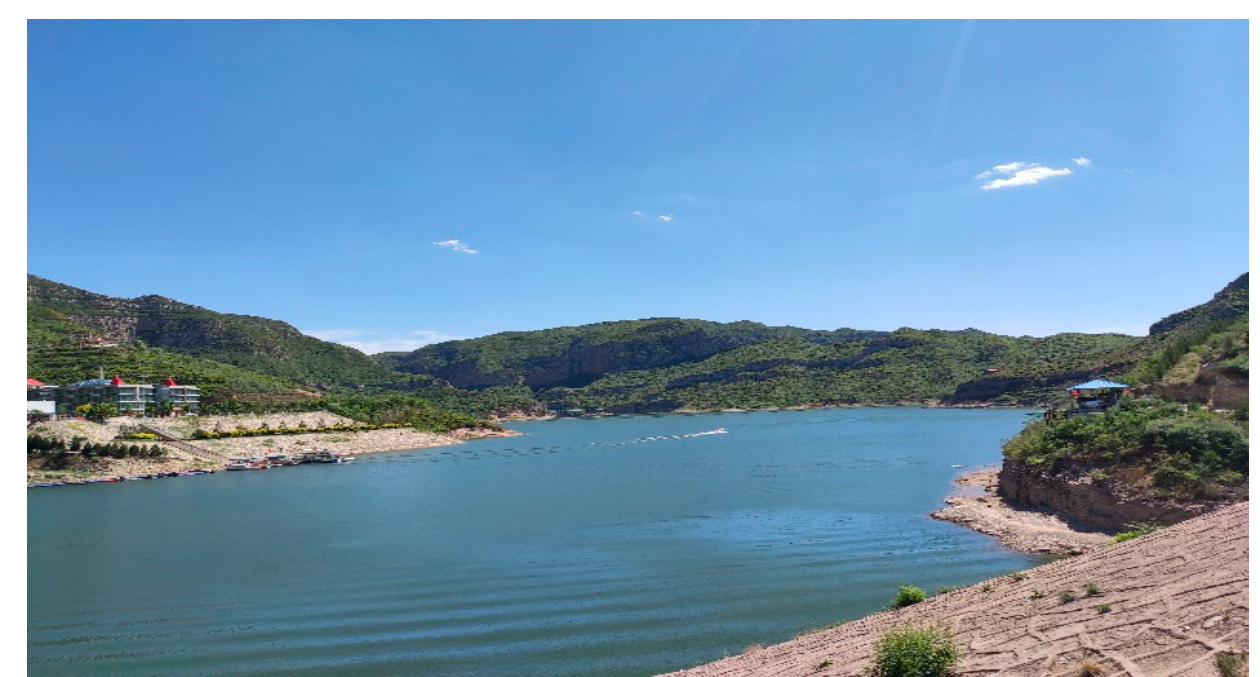
Figure 17. Reservoir environment.